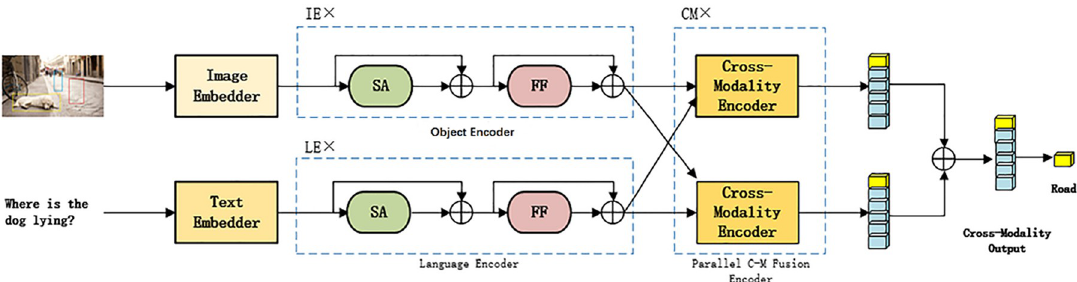
Fig 1. P-PCFL network framework. The model is mainly composed of three encoders, input pictures and corresponding questions, the model will return the answer to the question. For pictures of dogs, reprinted from [VQA Consortium] under a CC BY license, with permission from [VQA Consortium], original copyright